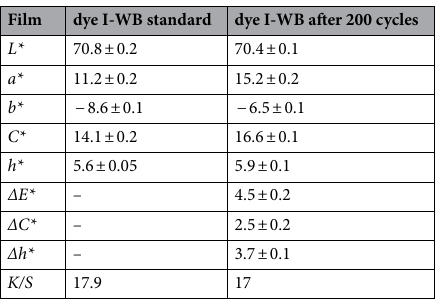
Table 1. The colour properties of the dye I -WB at wet-scrub